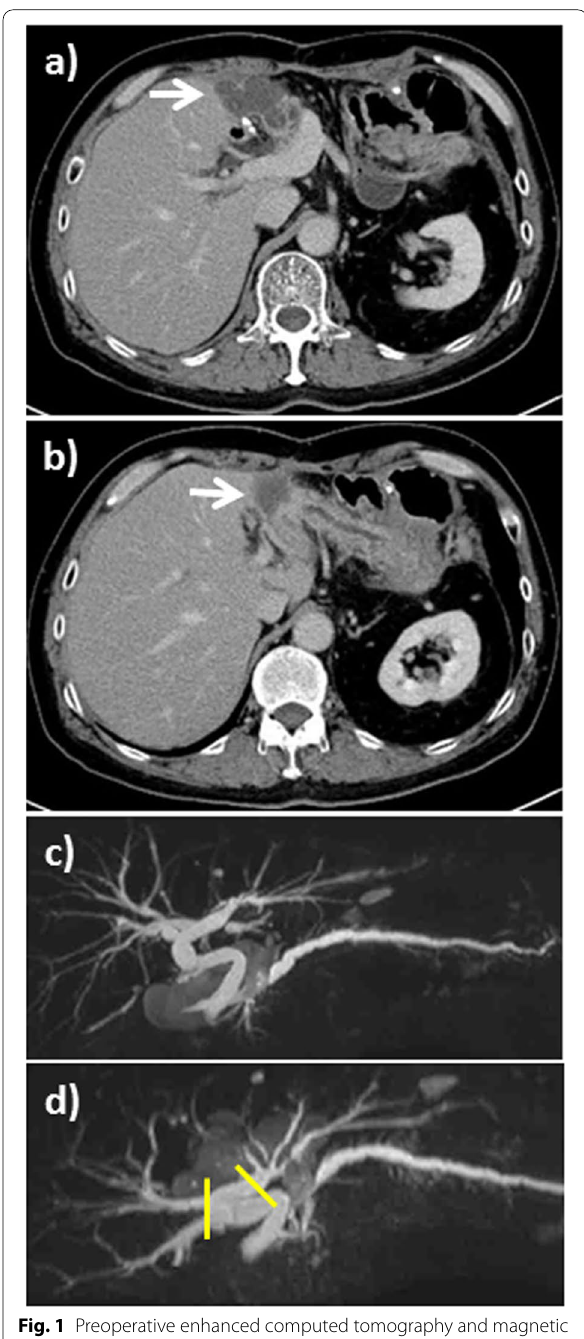
Fig. 1 Preoperative enhanced computed tomography and magnetic resonance imaging. a The white arrow shows the recurrent tumor in the hepatic hilum. b The white arrow shows the recurrent tumor in the hepatic hilum. The main pancreatic duct was dilated. c Tumor invasion to the main pancreatic duct and dilatation of the main pancreatic duct on its caudal side. d The yellow lines show the resection line of bile